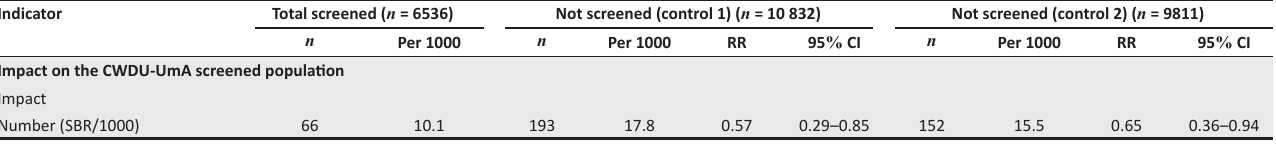
TABLE 1b: Comparison of the continuous wave Doppler ultrasound of the umbilical artery screened group and control groups 1 and 2. Indicator